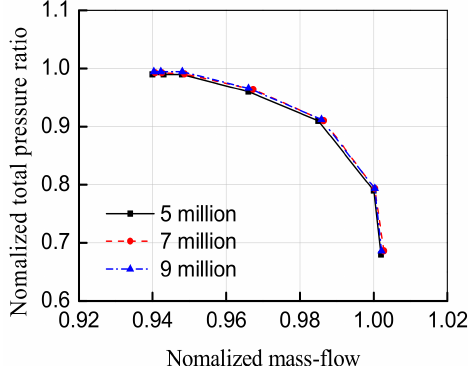
Figure 3. The verification of the computational grid independence.